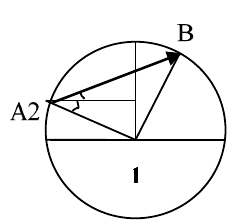
Figure 9. Simulation diagram of node moving radius.